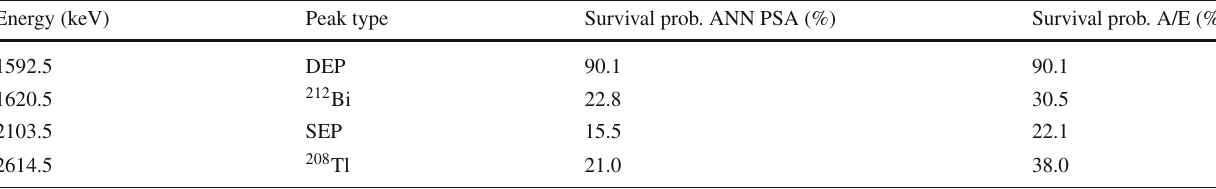
Table 1 Acceptances of events from various peaks present in the 228 Th last column contains, for comparison purposes, PSA results obtained with A/E